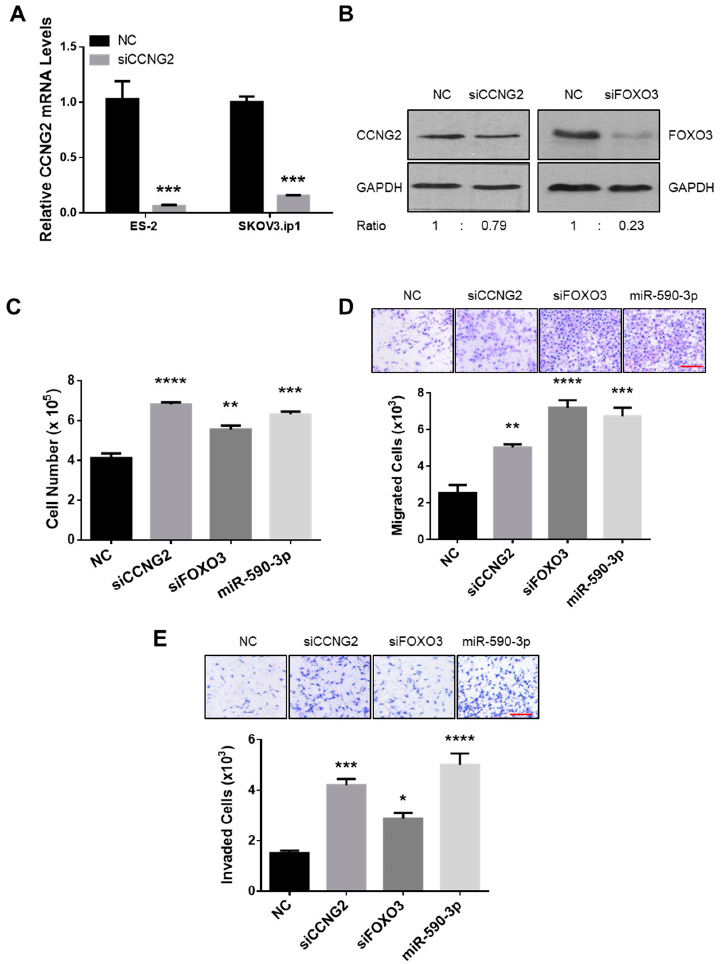
Figure 3. Silencing of CCNG2 or FOXO3 mimicked the effects of miR-590-3p. ( A ) ES-2 and SKOV3.ip1 cells were transiently transfected with a siRNA-targeting CCNG2 and a non-targeting oligonucleotide (NC). Real-time PCR confirmed the down-regulation of CCNG2 mRNA after siCCNG2 transfection. ( B ) Transient transfection of siCCNG2 and siFOXO3 into ES-2 cells reduced the protein levels of CCNG2 and FOXO3, respectively. ( C ) ES-2 cells were transiently transfected with siCCNG2, siFOXO3, miR-590-3p, or NC, and cell numbers were determined at 48 h after transfection. ( D ) SKOV3.ip1 cells were transiently transfected with siCCNG2, siFOXO3, miR-590-3p, or NC, and cell migration was determined. siCCNG2, siFOXO3, and miR-590-3p all significantly increased the number of migrated cells when compared to NC. ( E ) ES-2 cells were transiently transfected with siCCNG2, siFOXO3, miR-590-3p, or NC. Silencing of CCNG2 or FOXO3, or the overexpression of miR-590-3p induced cell invasion. Red scale bar (D and E) = 25 µ m. Data represent the mean ± SEM ( n = 3). Statistical analyses were performed using Student’s t -test (A), or one-way ANOVA/Student–Newman–Keuls test (C, D, and E). * p < 0.05, ** p < 0.01, *** p < 0.001, **** p <